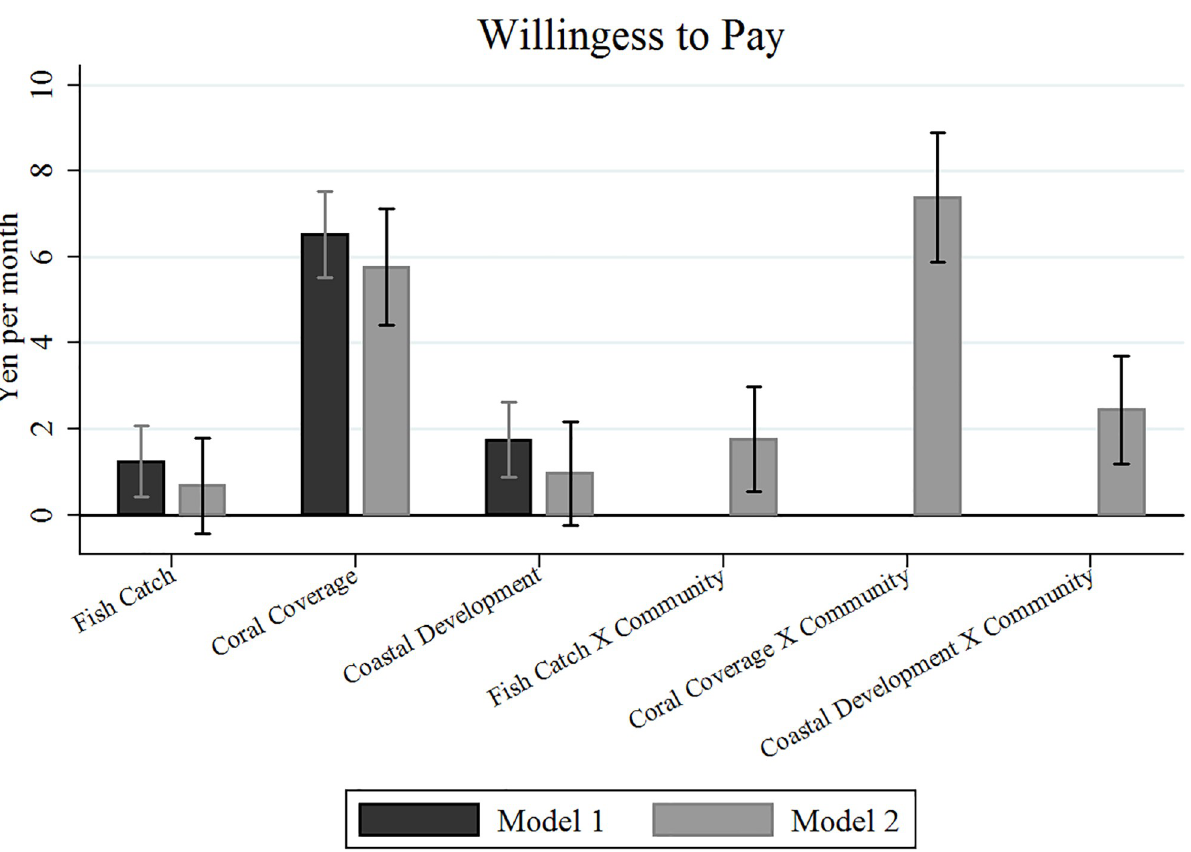
Fig 1. Valuation of the selected marine management